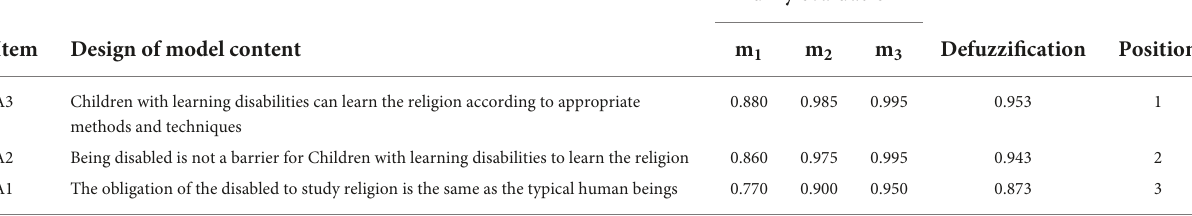
Fuzzy evaluation